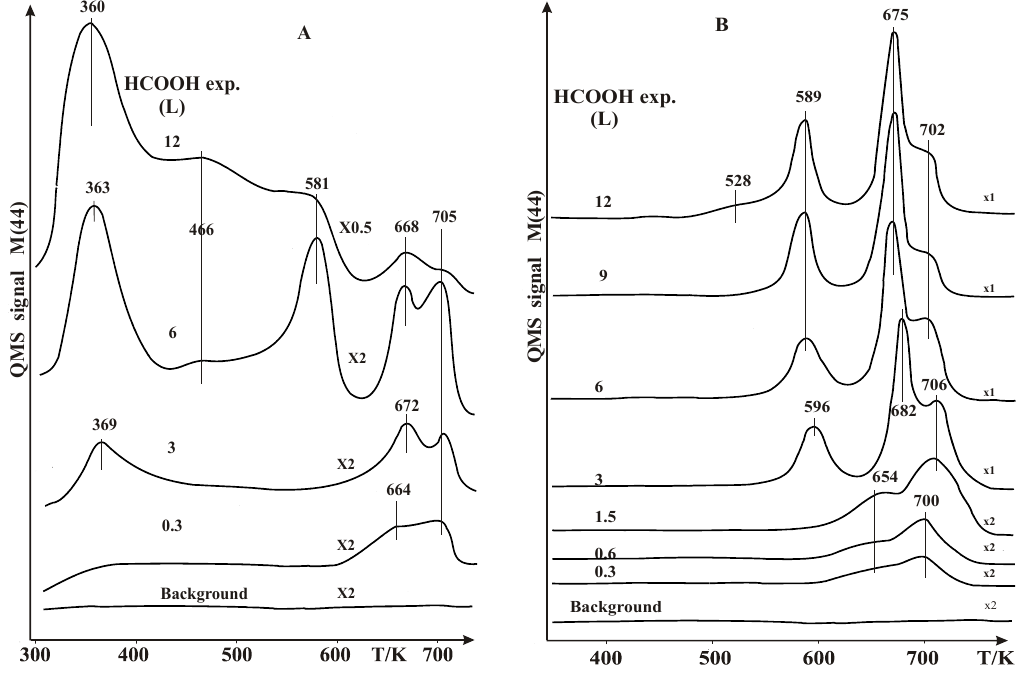
Figure 4. ( A ) Thermal desorption spectra of CO 2 at Θ K = 0.2. ( B ) CO 2 desorption spectra at monolayer K coverage, ( Θ K = 0.3) as a function of HCOOH exposure.